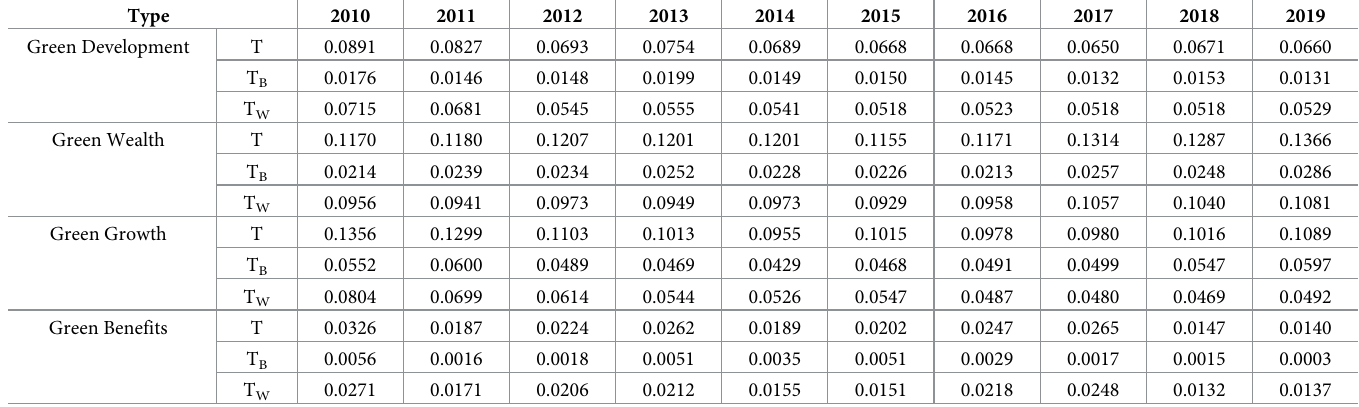
Table 2. Results of China’s green-development level and its composition index from 2010 to 2019 applying Theil index.